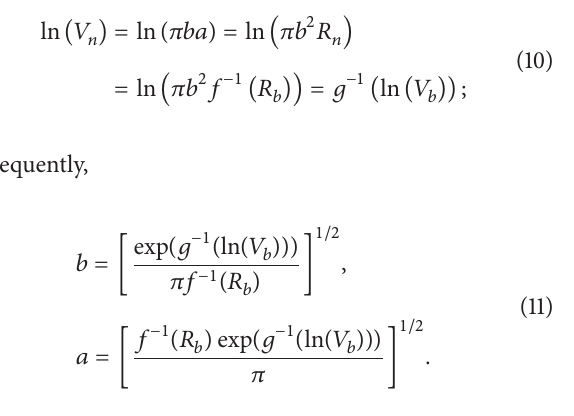
Figure 3: Evolution of the mean temperature as function of the nanowire aspect ratio 𝑅 𝑛 after formation of the bubble for the three wavelengths on 𝑀 𝐹 .